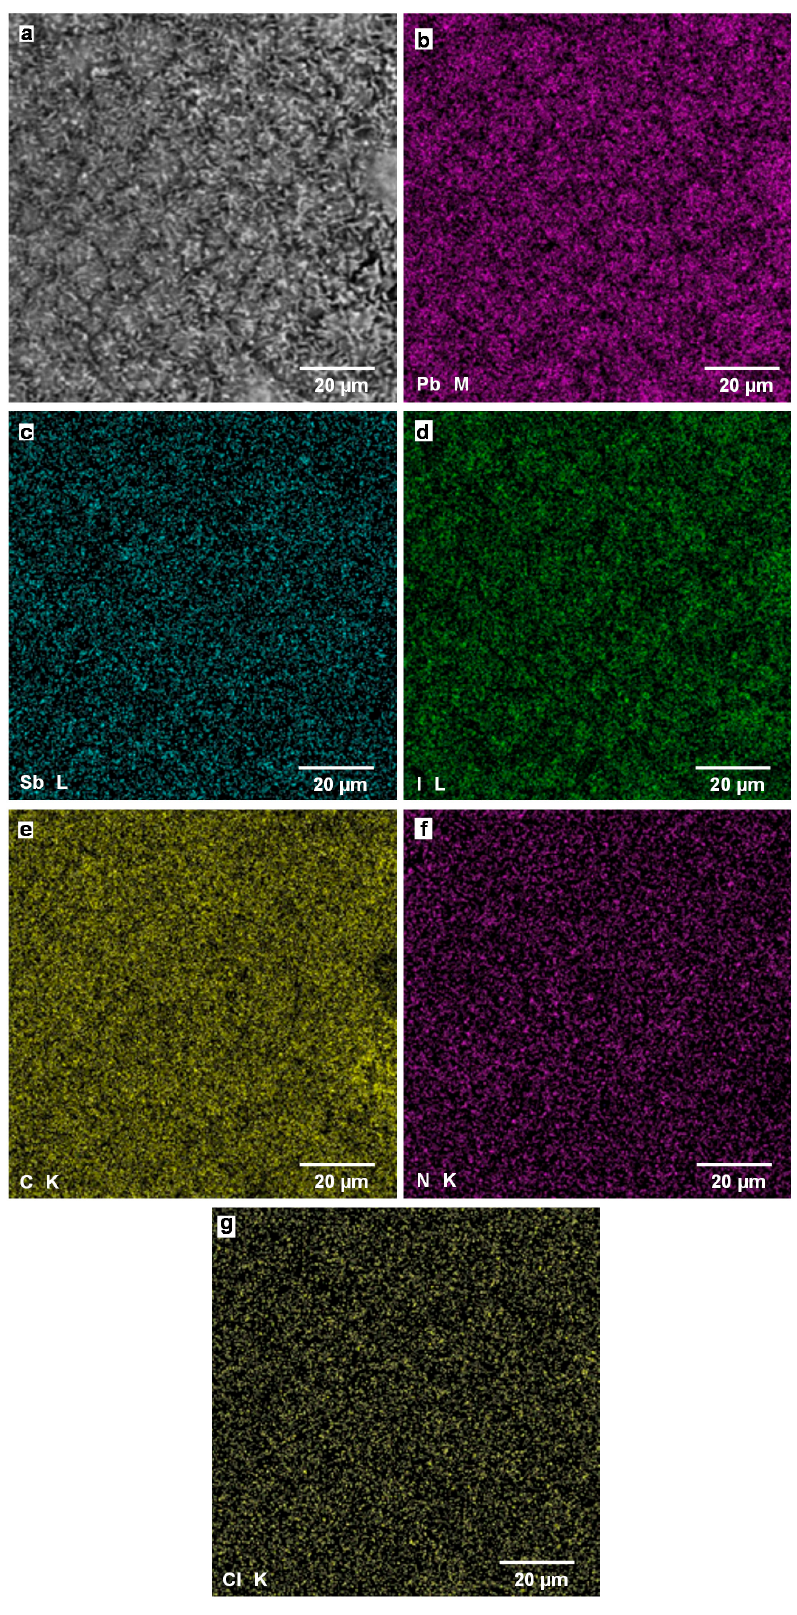
Figure 9. ( a ) SEM image of CH 3 NH 3 Pb(Sb)I 3 (Cl) cell with additives of SbI 3 with NH 4 Cl. Elemental mapping images of ( b ) Pb M line, ( c ) Sb L line, ( d ) I L line, ( e ) C K line, ( f ) N K line, and ( g ) Cl K line.